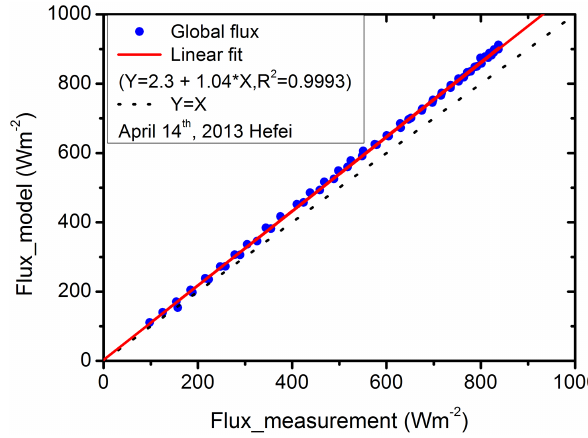
Figure 2. The corresponding instantaneous DARF values using the original (red) and daily averaged (black) AOP in Fig. 1, the 24-h average F values with the absolute (blue) and relative biases (ma- genta) are included as well in the inset.